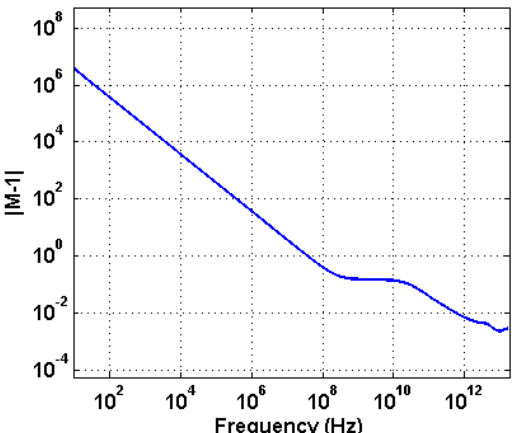
Fig.3: Log plot for the difference of the admittance ratio M from unity, which shows that approximately from f=100 MHz onwards, the presence of membrane becomes insignificant in the overall